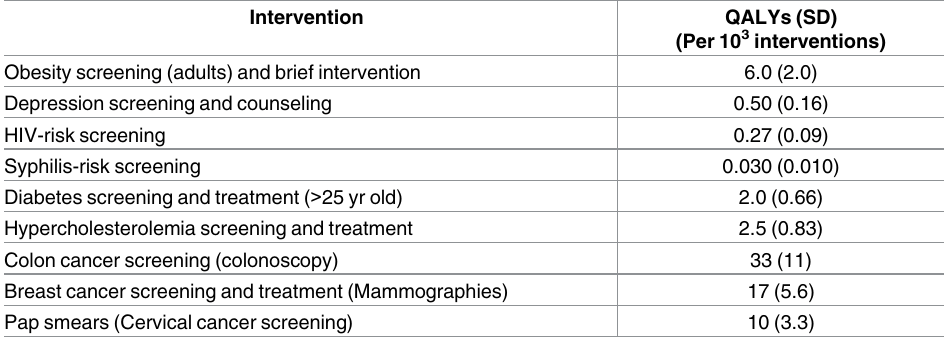
Table 2. Interventions with estimated coefficients of variation.